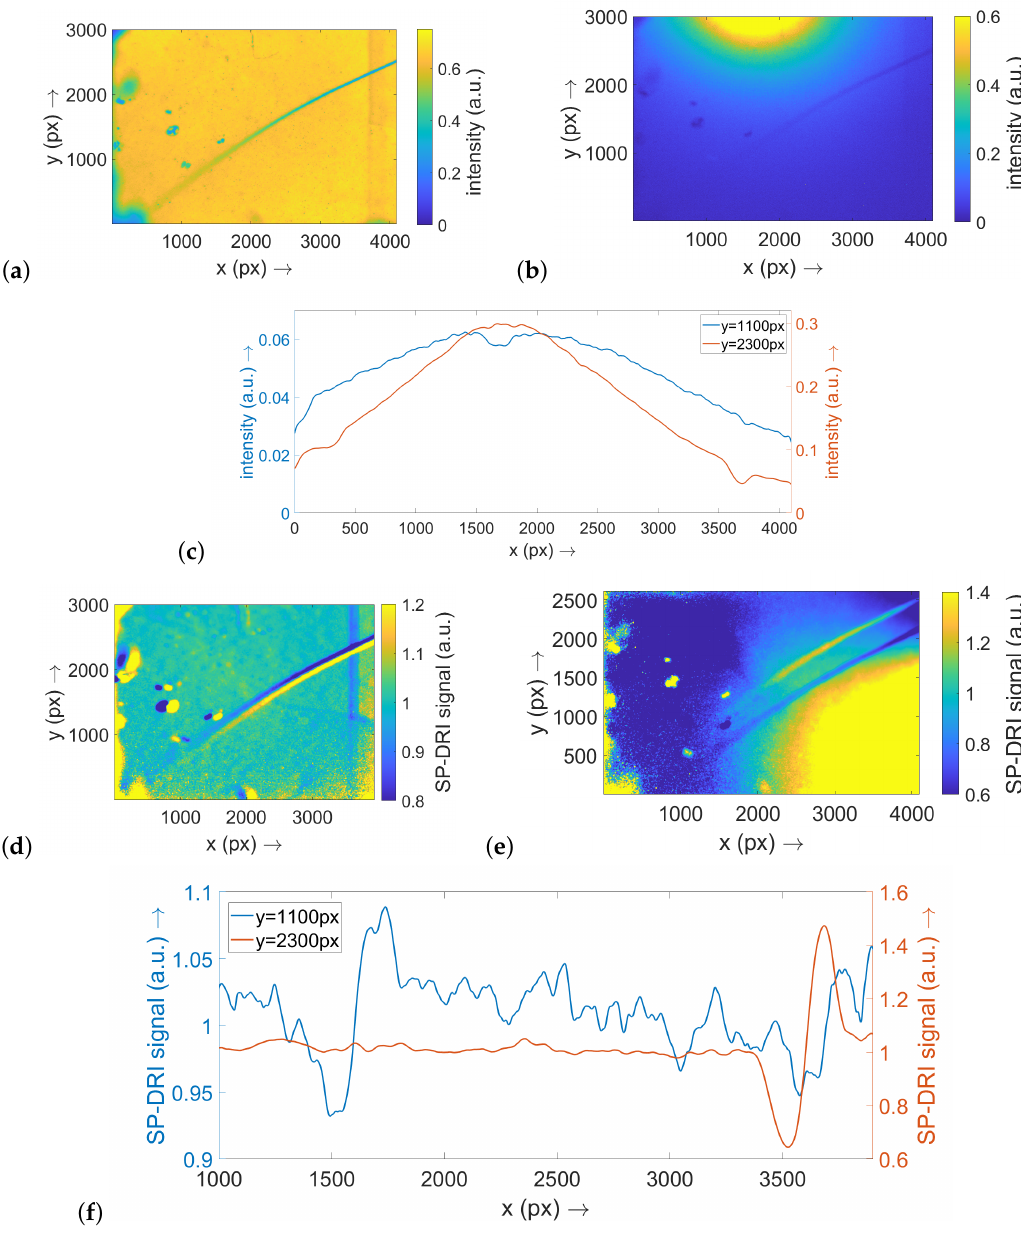
Figure 4. This figure shows the results for the optical phantoms for the configuration with a thread of 20µm diameter. As the single subillustrations are systematically corresponding to Figure 3, their description can be looked up there accordingly. Note: ( a – c ) are scaled to